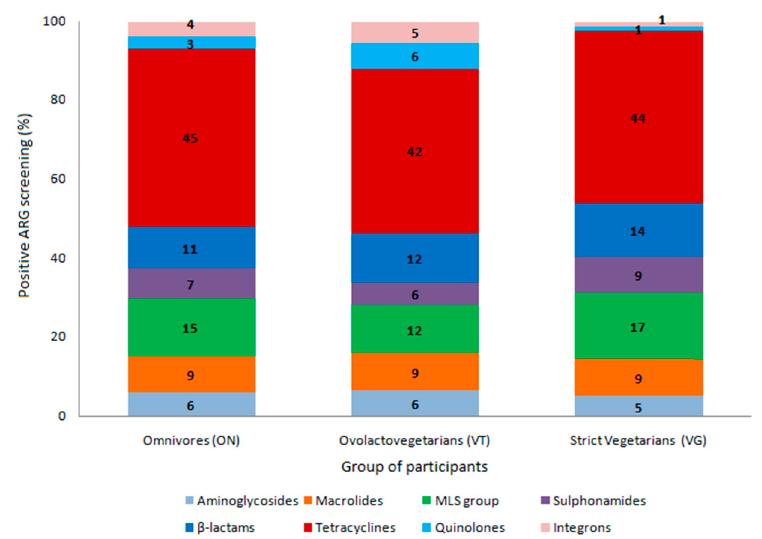
Figure 1. Frequency of detection of antimicrobial resistance genetic markers (ARG) related to different classes of antimicrobial drugs according to positive screening by PCR from the fecal metagenome of omnivores (ON), ovolactovegetarians (VT), and strict vegetarians (VG). ARG are clustered based on their chemical structure or phenotype, such as β -lactams ( bla CTX-M , bla TEM , bla SHV , blaZ , mef ); tetracyclines ( tet(A) , tet(B) , tet(E) , tet(L) , tet(M) , tet(O) , tet(Q) ); macrolide, lincosamide, and streptogramin (MLS) group ( ermA , ermB , ermC ); quinolones ( qnrB , qnrS ); sulfonamides ( sul1 , sul2 ); aminoglycosides ( aacA-aphD ); and integrons ( intl-1 , intl-2 ).